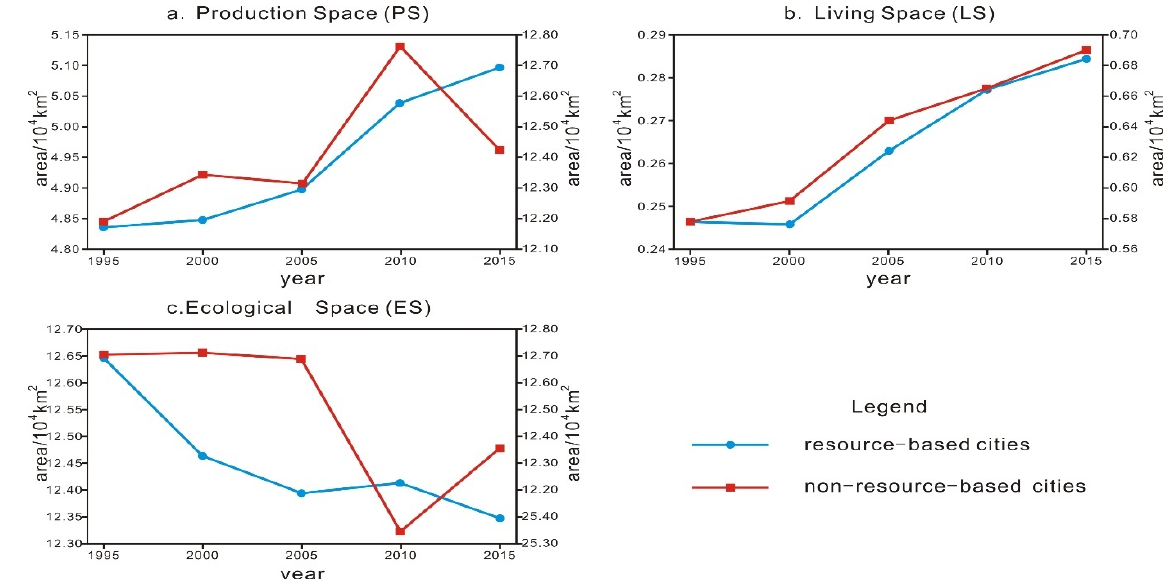
Figure 2. Change trend of the PLES of the two types of cities in the middle reaches of the Yangtze River. Note: The left longitudinal axis indicates the resource-based cities, and the right longitudinal axis indicates the non-resource-based cities. Table 3. Change trend of the PLES of the two types of cities in the middle reaches of the Yangtze River, 1995–2015.